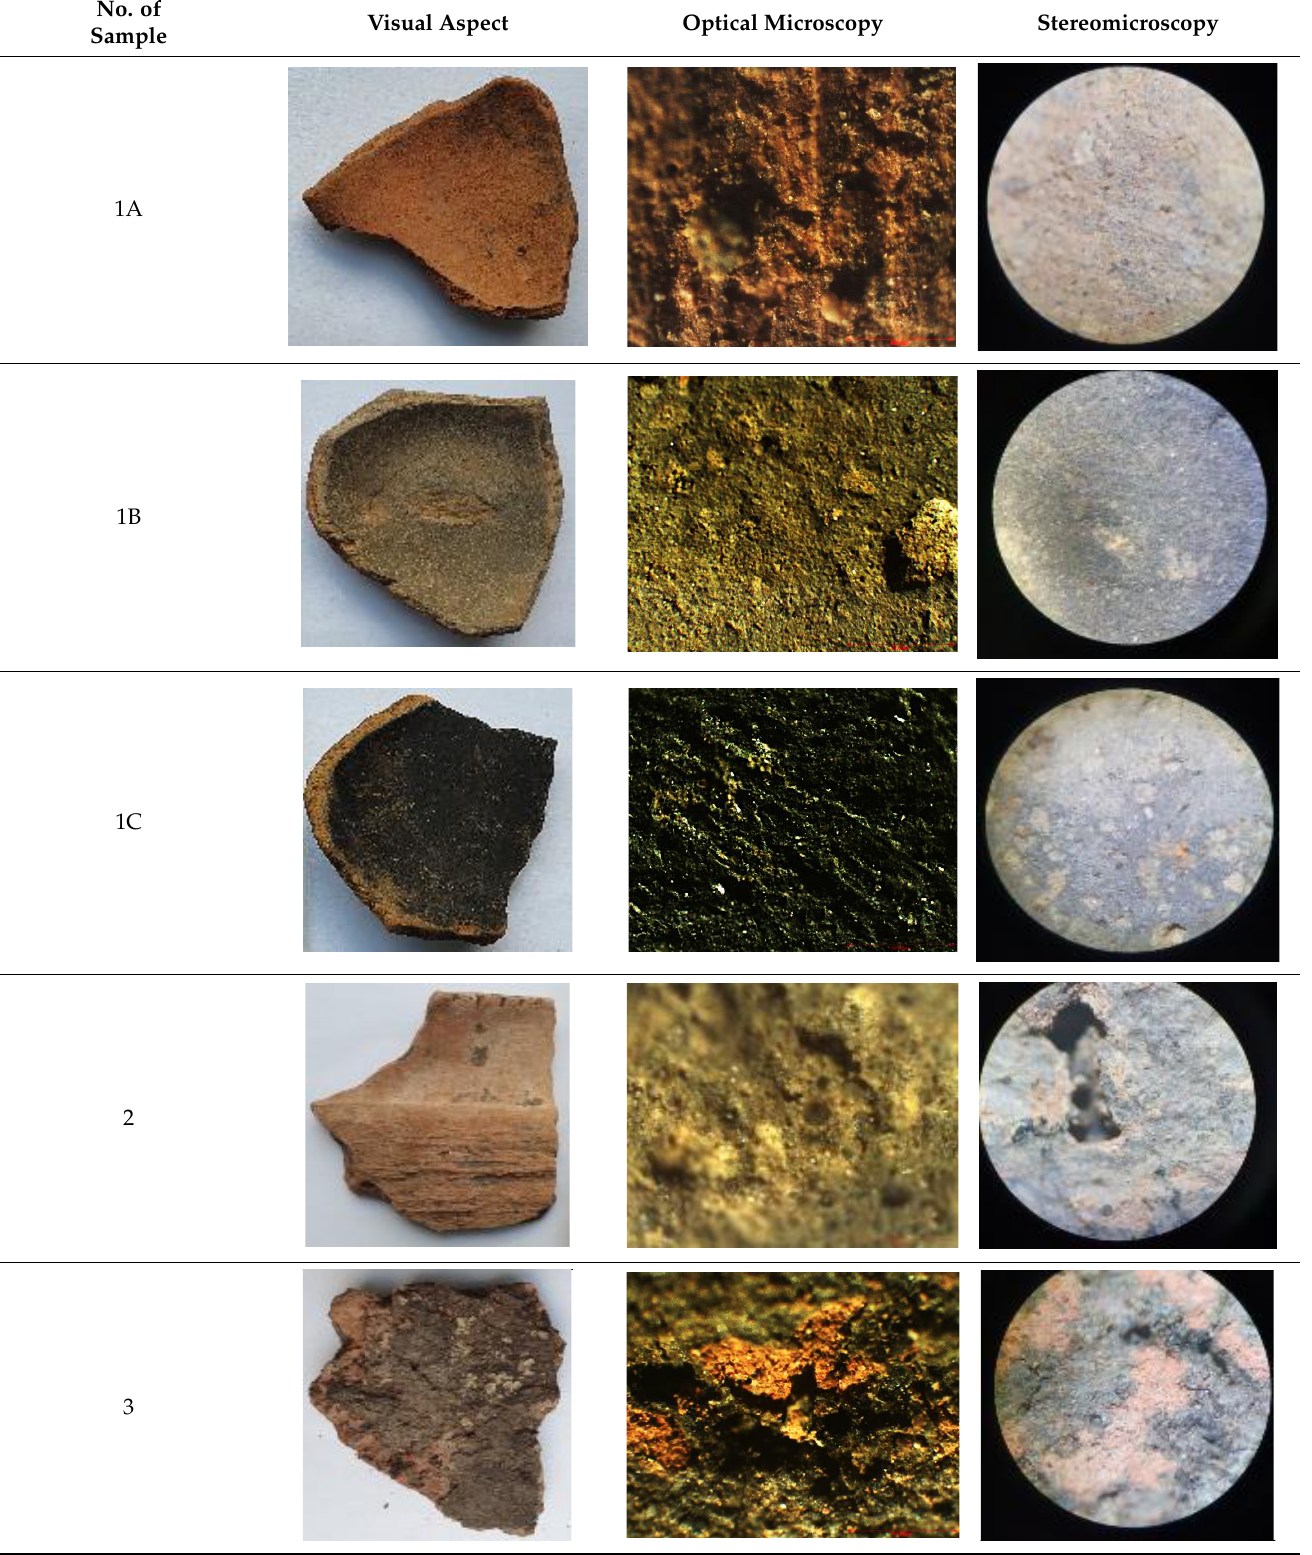
Table 1. The sample labeling: Codification, photos, optical and zoom microscopy images of the studied pottery fragments.